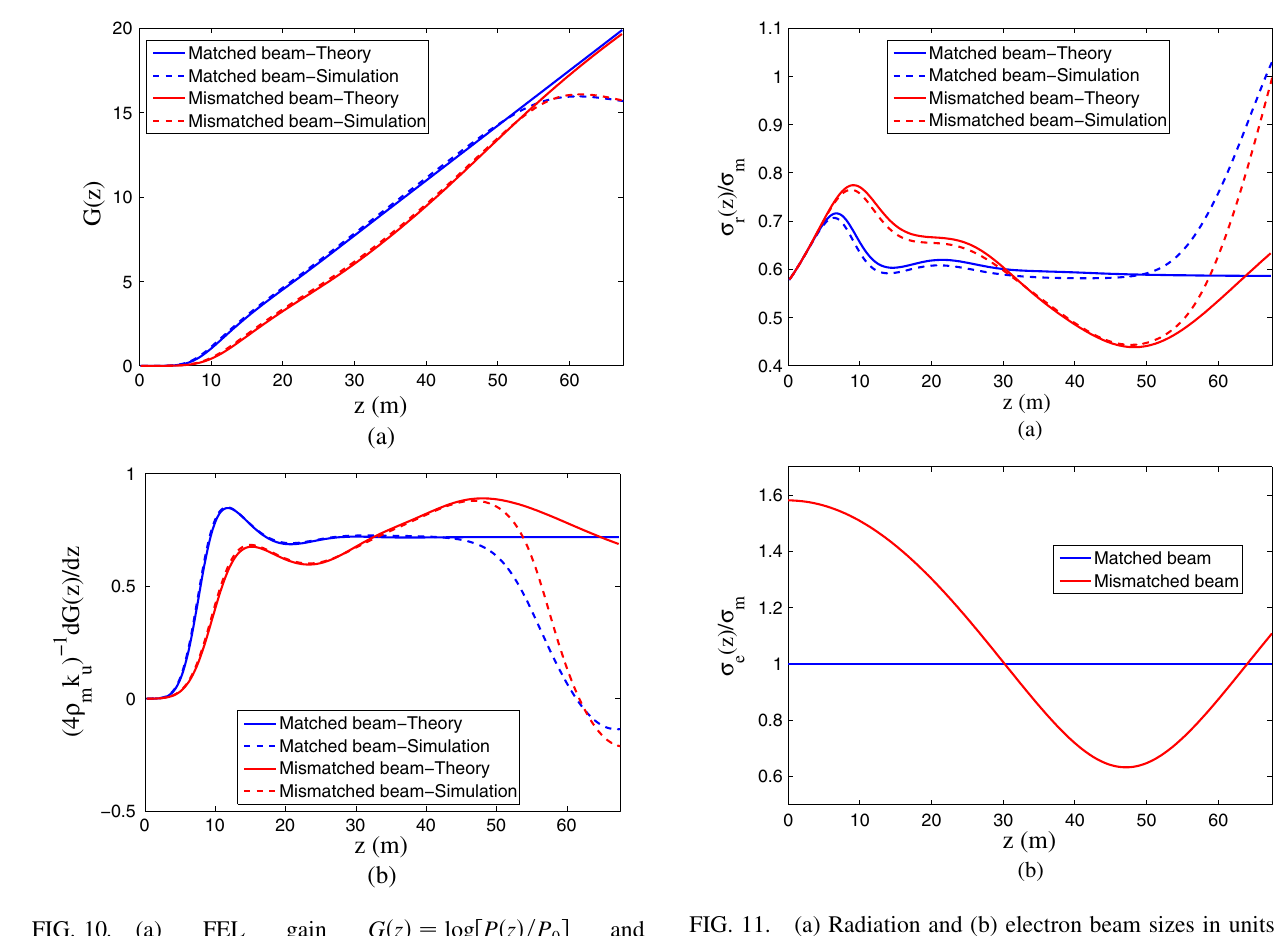
FIG. 10. (a) FEL gain G ð z Þ ¼ log ½ P ð z Þ =P (b) normalized local power growth rate ð 4 (cid:13) for a matched (blue curves) and a mismatched beam (red curves)—LCLS parameters. Both analytical results (solid curves) and GENESIS simulation data (dashed curves) are